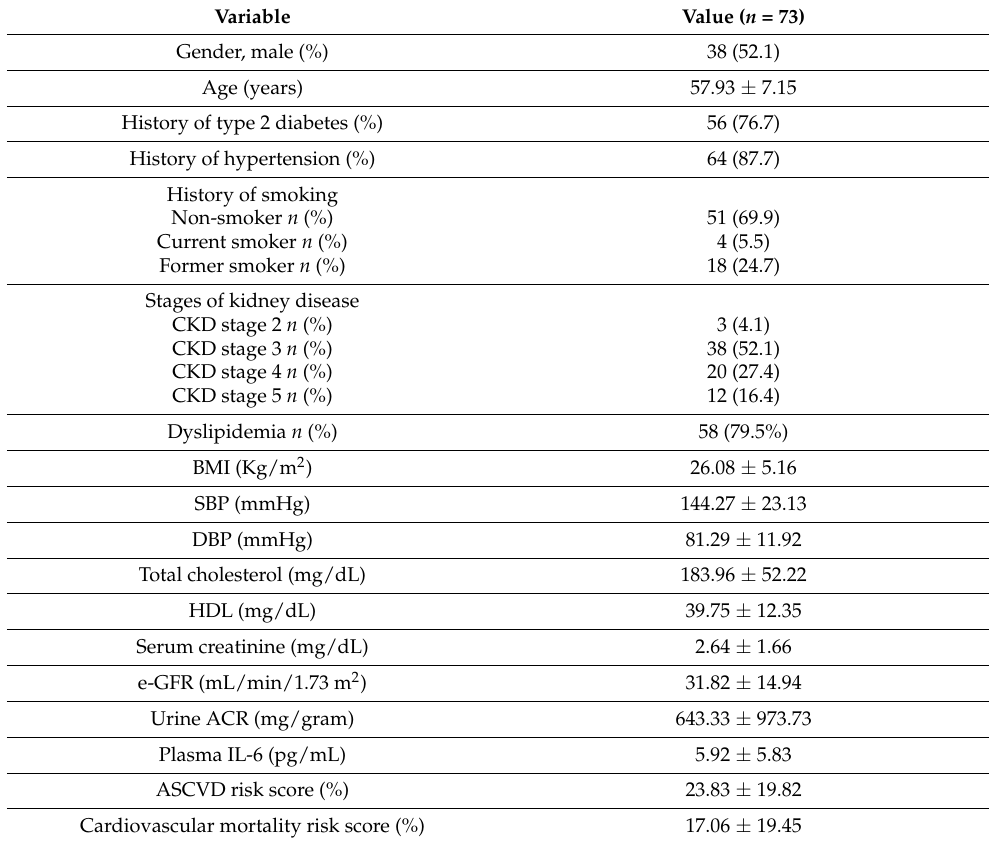
Table 1. Characteristic of the Javanese CKD patients in this